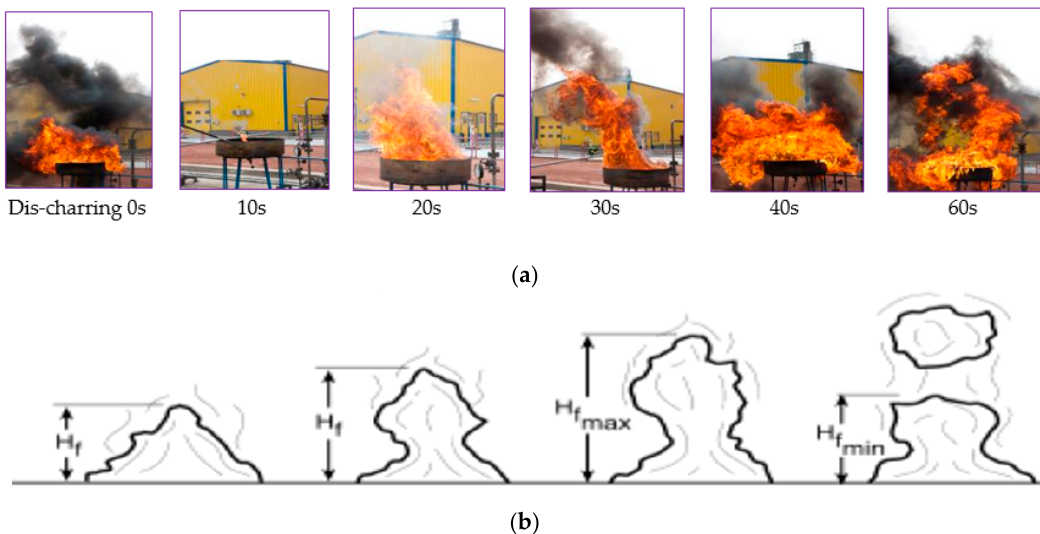
Figure 5. Flames of gasoline pool fire. ( a ) Typical pictures of fire expansion phenomenon of gasoline pool fire. ( b ) Characteristics of Flame Height Fluctuations [23].